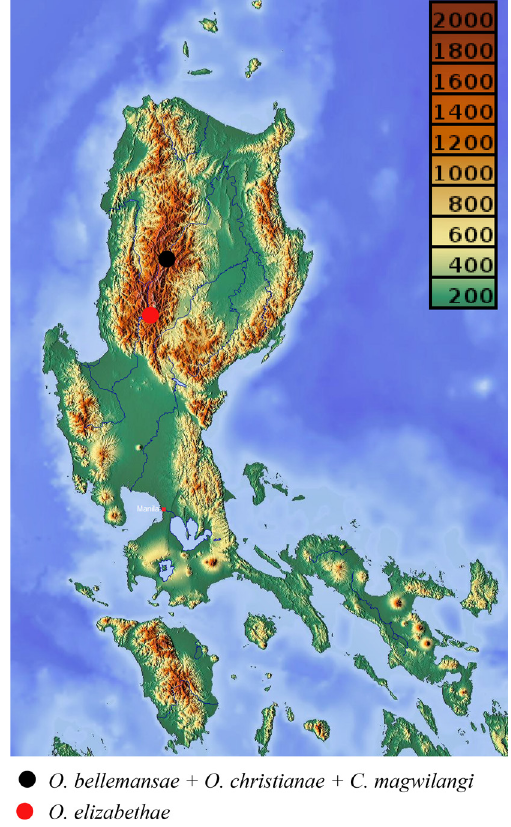
Fig. 13. Otraleus spp. and Capuyanus magwilangi sp. nov. Distribution map in